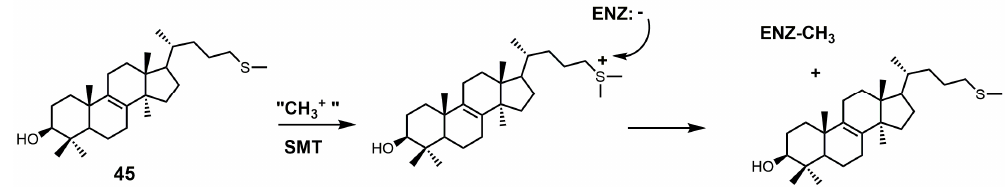
Figure 26. Proposed inhibitory mechanism of SMT with 25-thialanosterol (adapted from [4]).